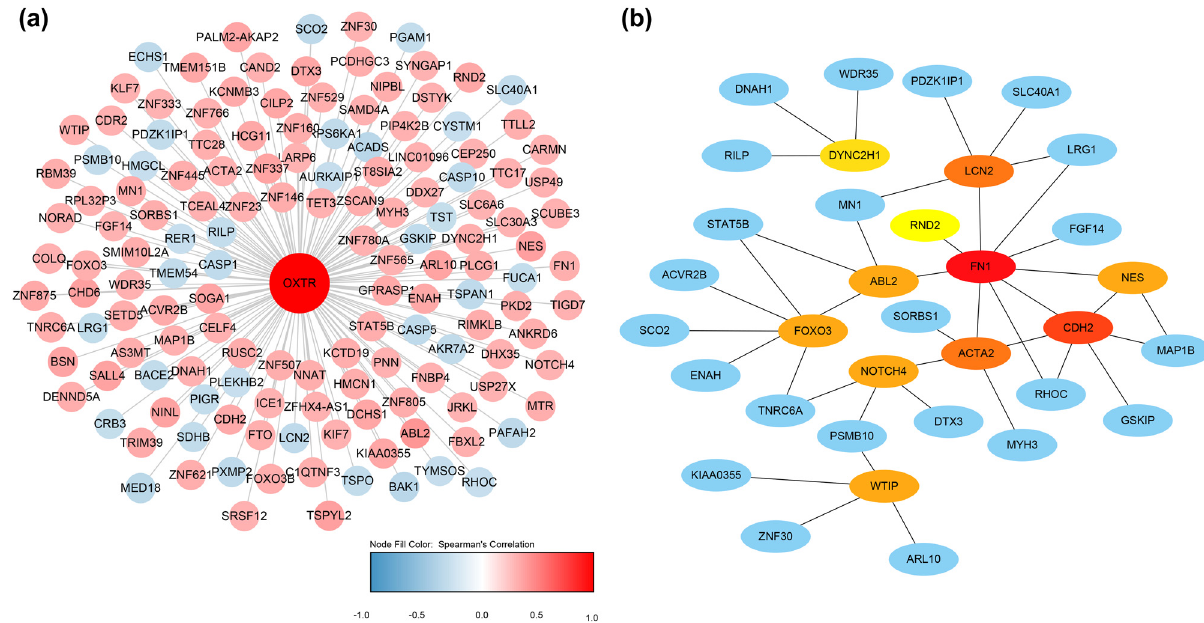
Figure 7: PPI and gene co - expression network analysis. ( a ) Hub genes of the PPI network. ( b ) Gene co - expression networks. Blue indicates genes that are negatively related to OXTR, and red indicates genes that are positively related to OXTR. The darker the color, the stronger the